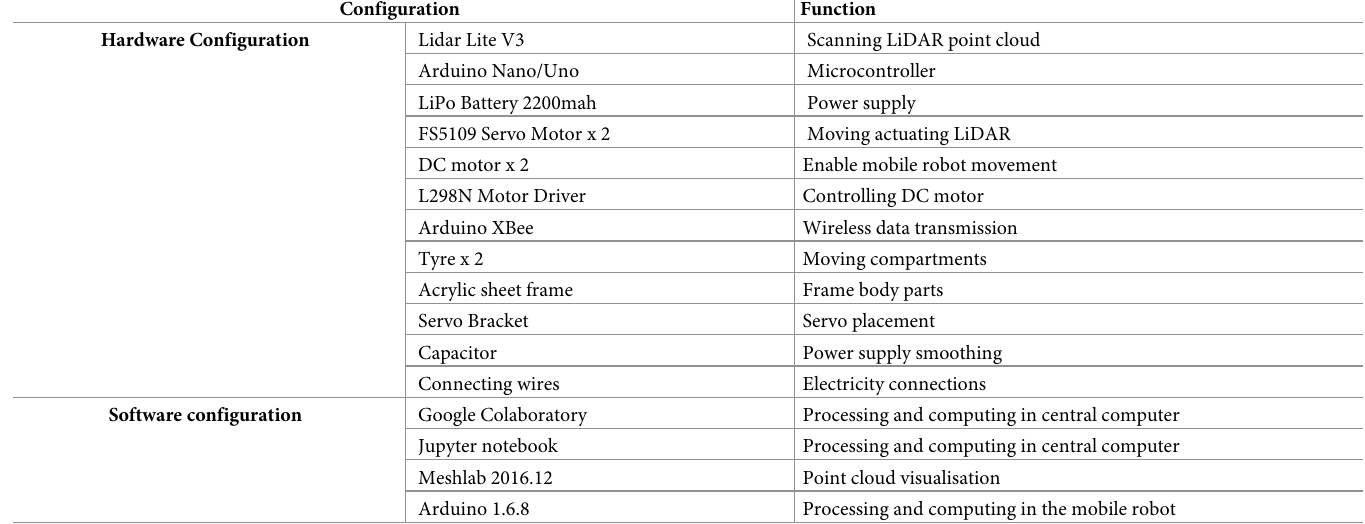
Table 3. Complete hardware and software